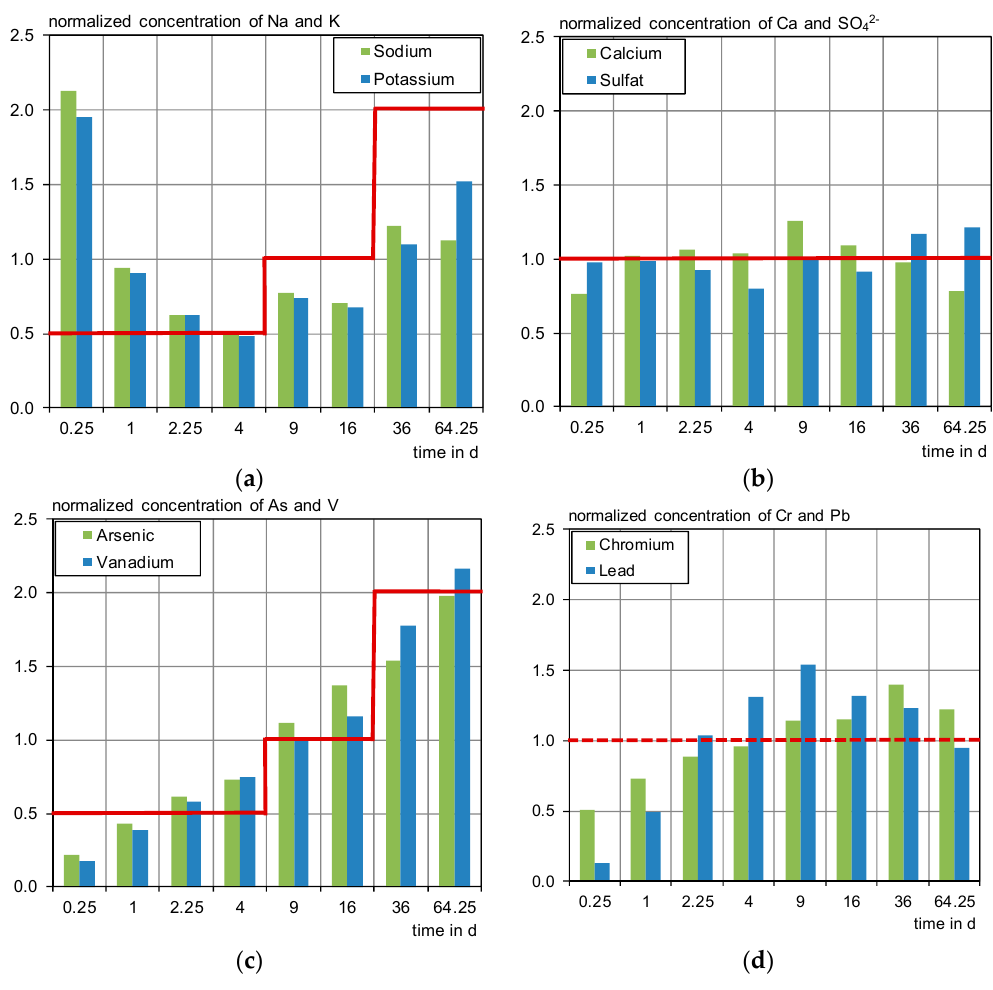
Figure 21. Leaching mechanism, three-step diagram after CEN/TS 16637-2. ( a ) Sodium and potassium, diffusion controlled with initial wash-off effect;( b ) calcium and sulfate, solubility controlled; ( c ) arsenic and vanadium, diffusion controlled; ( d ) chromium and lead, no mechanism determined.